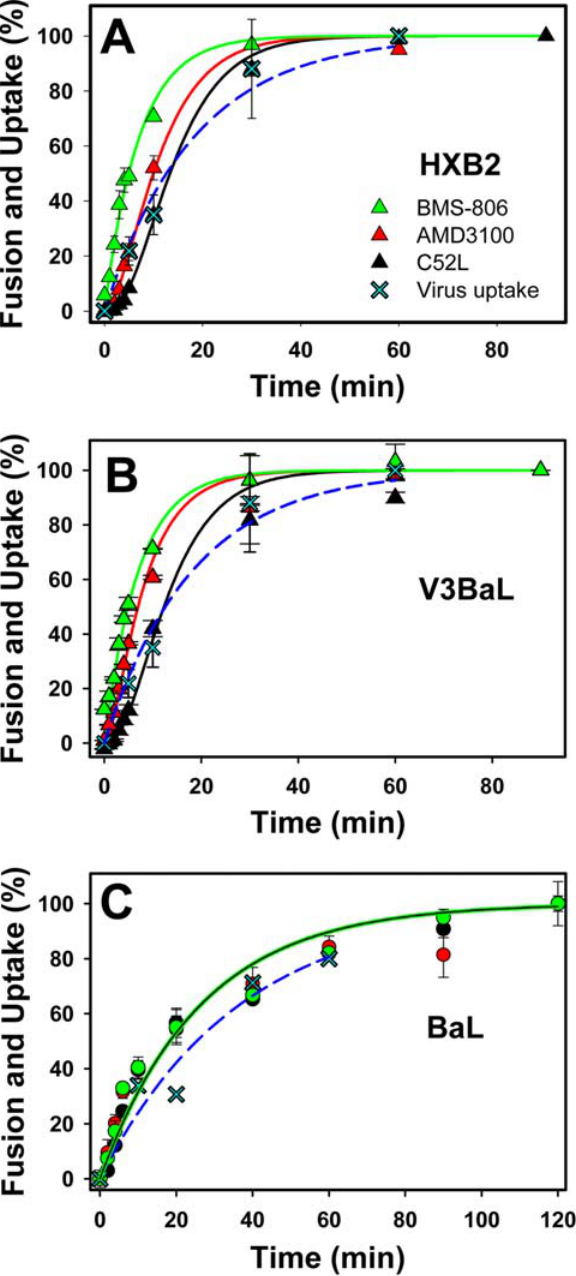
Figure 3. Progression of the HXB2, V3BaL and BaL through surface-accessible stages of fusion. (A) The kinetics of HXB2 binding to CD4 and CXCR4 was determined by the time-of-addition experiments using BMS-806 and AMD3100 (see also Fig. 1B), and the rate of productive endocytosis was measured by adding C52L. (B, C) The rates of CD4 and CCR5 engagement by V3BaL (B) and BaL (C) were determined by adding BMS-806 and AD101, respectively. The kinetics of receptor-mediated virus endocytosis was measured by escape from C52L. In all panels, the bulk HIV-1 uptake was determined by accumulation of the intracellular p24 (cyan crosses) and fitted with a single-exponential function (dashed lines). The solid lines were obtained by curve fitting the model equations to experimental points, as described in the text and in the legend to Figure 2. Since all early steps of BaL fusion occurred virtually simultaneously, only one theoretical curve is shown in panel C.